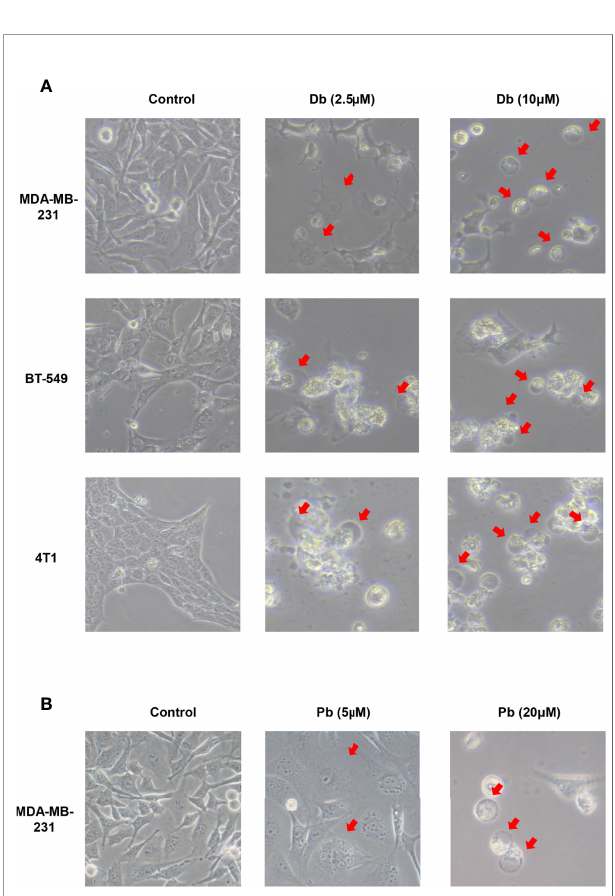
FIGURE 6 | Pyroptotic cell death induced by Dinaciclib and Palbociclib in TNBC cells. Representative phase-contrast images of Dinaciclib (A) and Palbociclib (B) treated cells with indicated concentration for 24 h. Original magni fi cation, ×400.